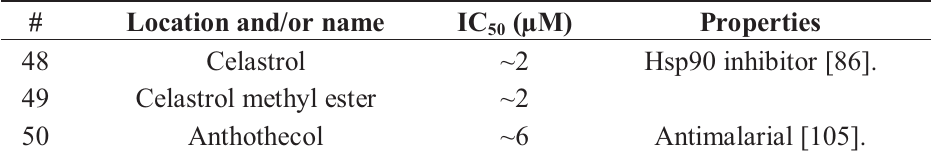
Table 5. Pentacyclic triterpenoids.